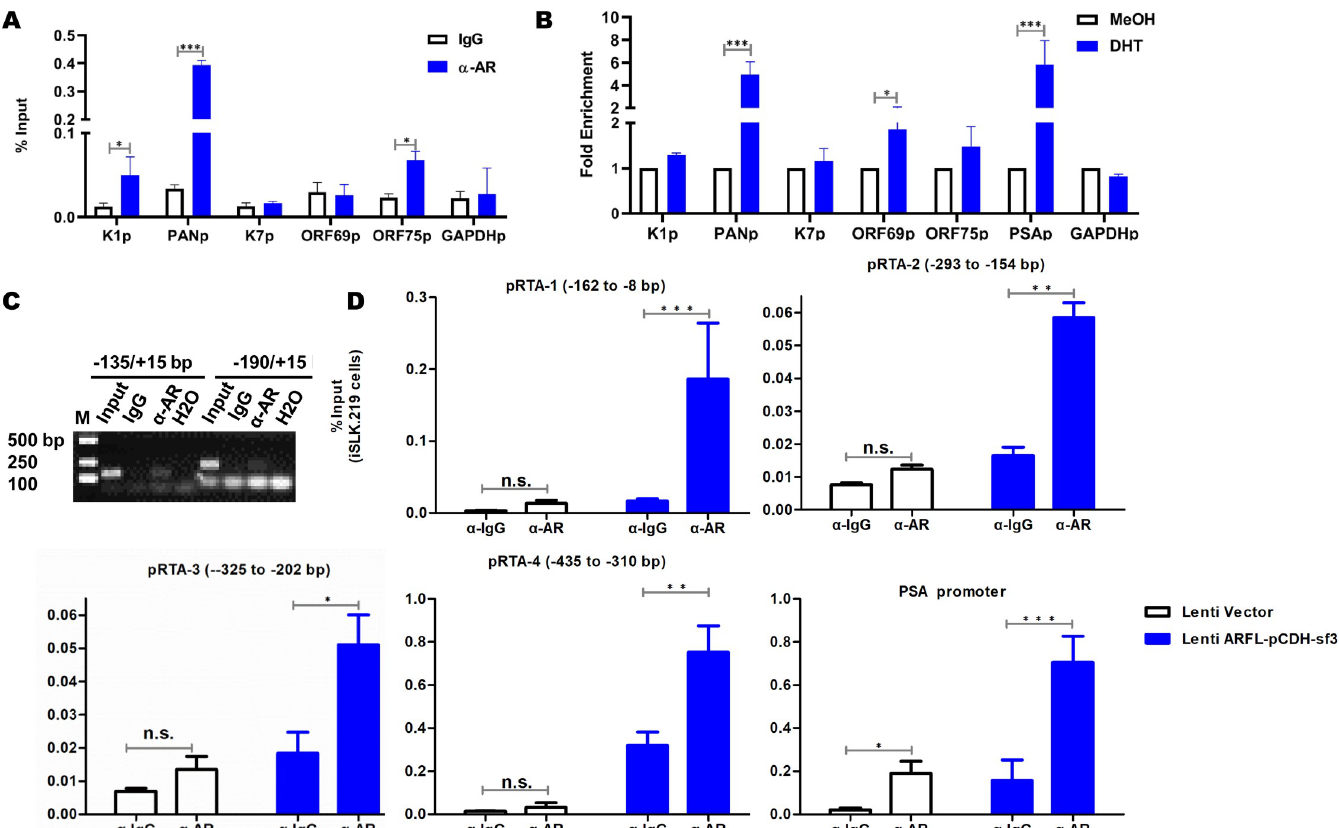
Fig 3. AR physically bound with the promoters of viral lytic genes in vivo . (A) Validation of the interaction between the AR with the promoter regions by ChIP-PCR detection. Anti-AR antibody and IgG control were applied in iSLK.219 cells, using the GAPDH locus as a negative control. The prostate-specific antigen region was detected as a positive control for AR binding. The data were normalized by the percent input method. (B) ChIP assays of AR in the DHT or MeOH solvent treatment. iSLK.219 cells were treated with DHT or MeOH for 24 h, followed by doxycycline induction for 48 h before ChIP assay. The data were normalized by the fold enrichment method (ChIP signals were divided by the IgG signals). The data are presented as means and SD. (C) DNA gel analysis on products from ChIP-qPCR assay using additional primers targeting the –135/+15 bp and –190/+15 bp segments upstream the TATA box on the PAN promoter. (D) Binding of AR in the extensive RTA promoter region was dependent on abundant AR expression. Four pairs of primers for the –435/–8 bp region on the RTA promoter were used. iSLK.219 cells were transduced with AR-expressing lentivirus or the vector control for 24 h, followed by doxycycline induction for 48 h, and then subjected to ChIP-PCR detection. ChIP- qPCR data were normalized by the percent input method. n.s., not significant; � P < 0.05; �� P < 0.01; ��� P < 0.001. Only the significant P value was indicated. Multiple independent experiments were performed at least in